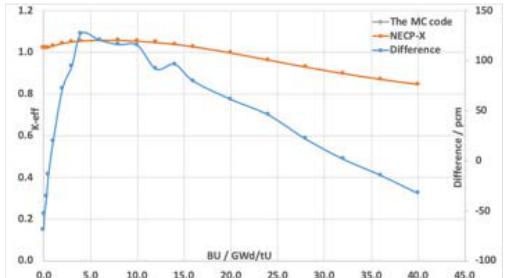
Figure 8. The k eff and difference for multi-annular fuel assembly with burnup problem